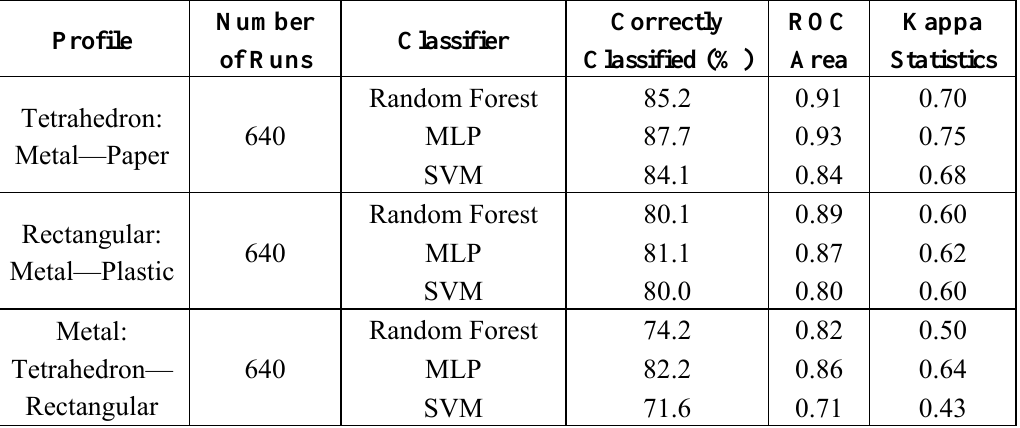
Table 8. Classification results using radar